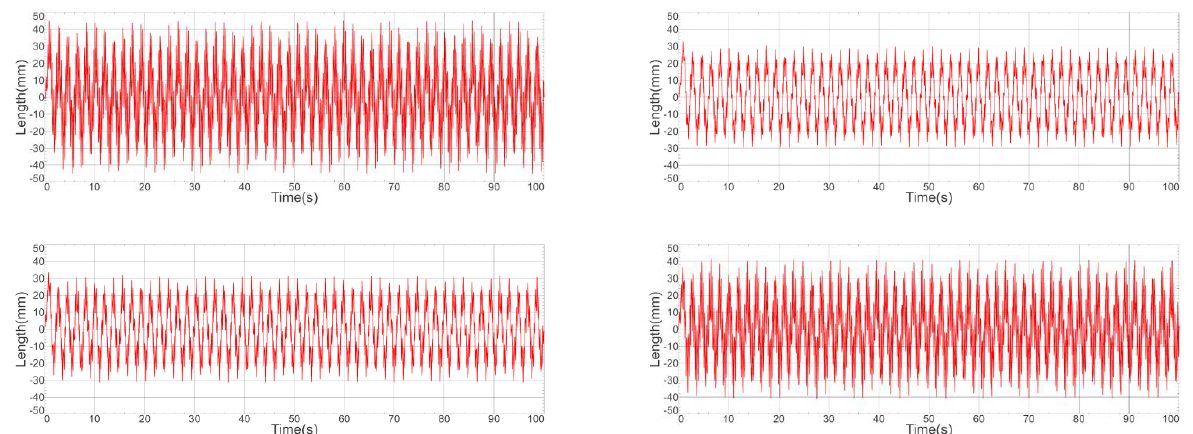
Figure 13. The displacements in time for storys m1, m2, m3, and m4 when using the vibration reduction force determined